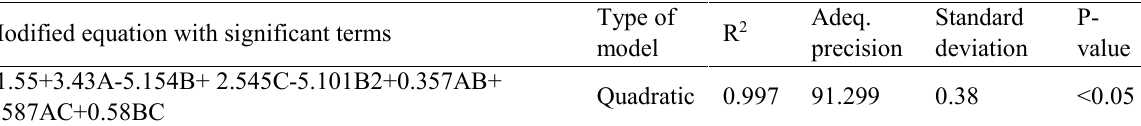
Table 3. ANOVA results for the equation of the Design Expert for MCPAC Modified equation with significant terms